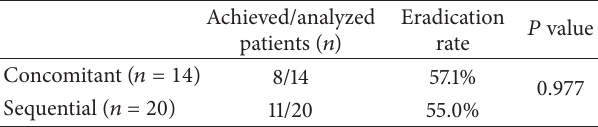
Table 3: Second-line eradication rates of Helicobacter pylori .